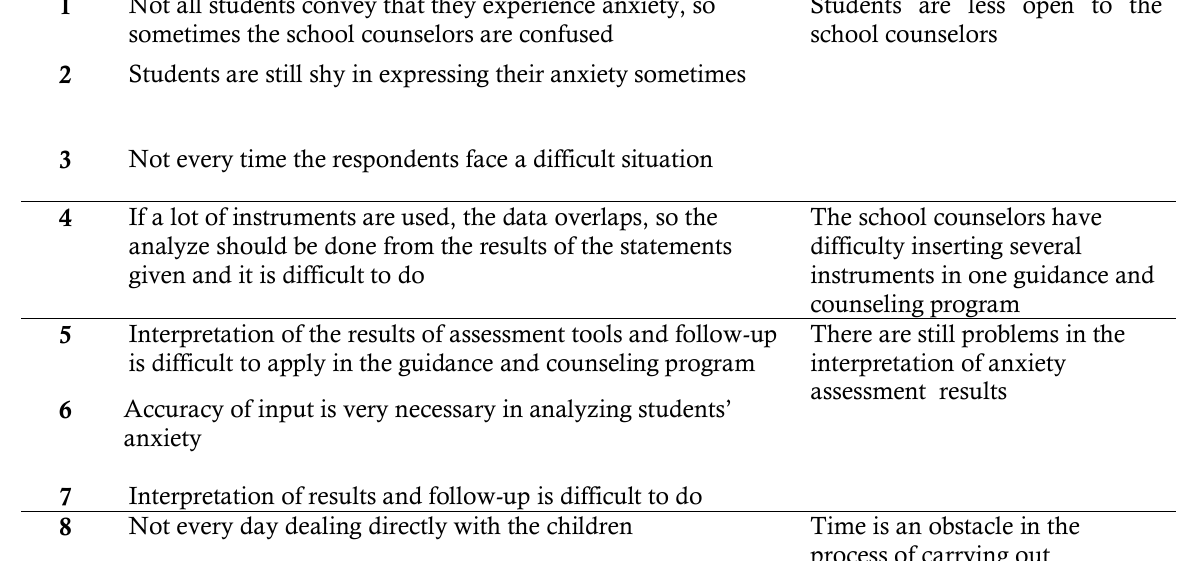
Table 5. The results of reduction of obstacles encountered when making assessments No.